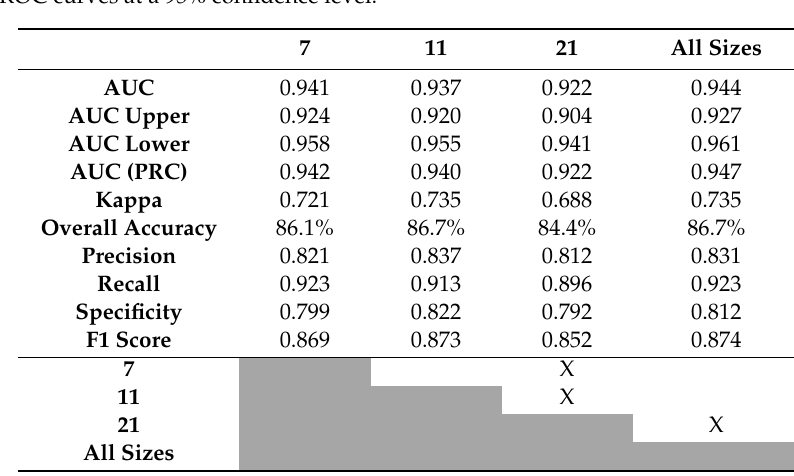
Table 7. Comparison of di ff erent window sizes. Lower and upper bounds represent a 95% confidence interval calculated using 2000 stratified bootstrap replicates. X indicates statistically significantly di ff erent ROC curves at a 95% confidence